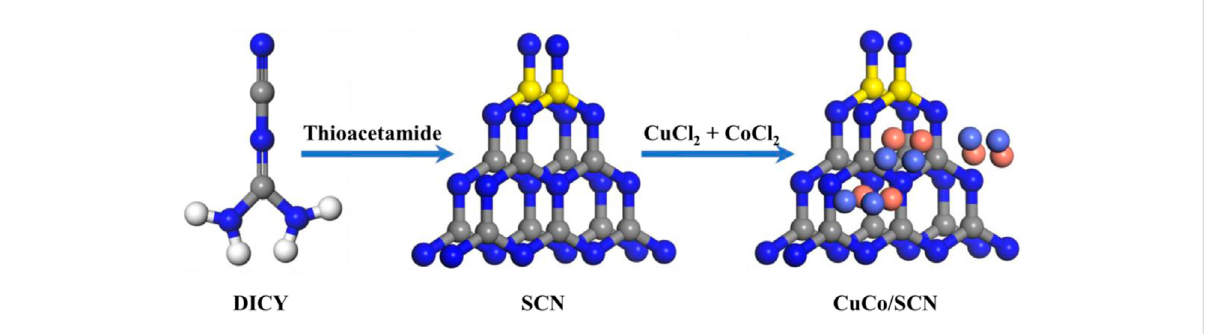
FIGURE 1 Preparation method of